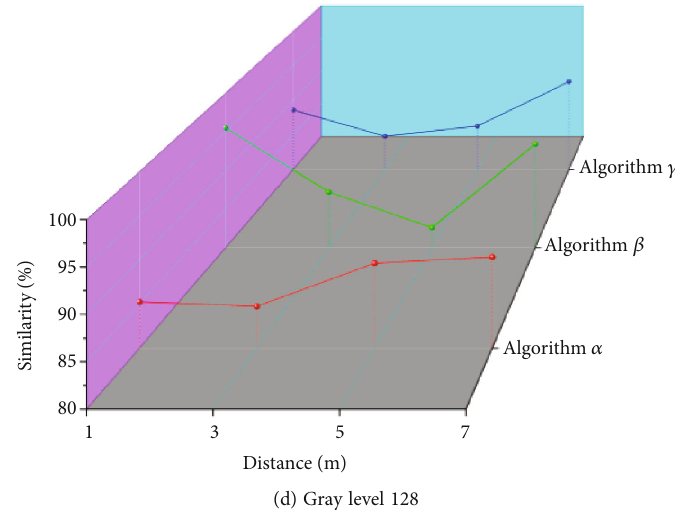
Figure 7: Curve comparison of image similarity at di ff erent gray levels.